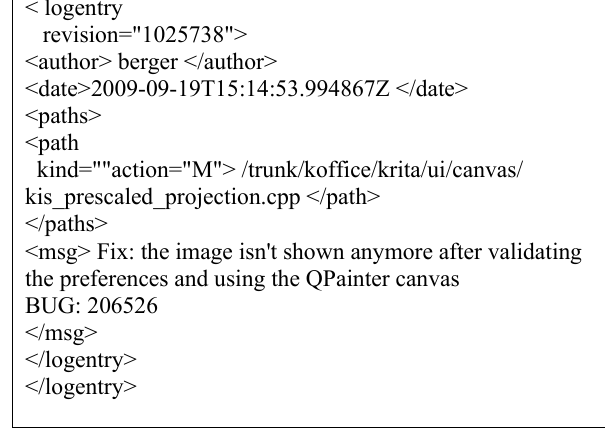
Fig. 1. A Snippet of an adaptive bug-fixing commit for the KOffice